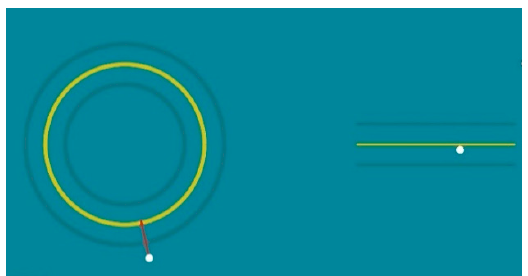
Figure 8. The EULRR prototype and subject testing. ( a ) the EULRR prototype; ( b ) the testing of the subject.